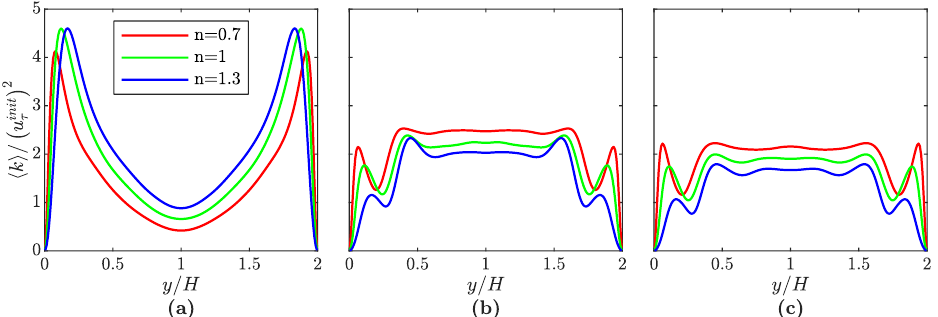
Figure 13. Average turbulent kinetic energy (cid:104) k (cid:105) , normalized by ( u init τ ) 2 , as a function of the wall- normal coordinate for the single-phase ( a ) and the two-phase setups with Eo = 0.3125 ( b ) and Eo = 3.75 ( c ).